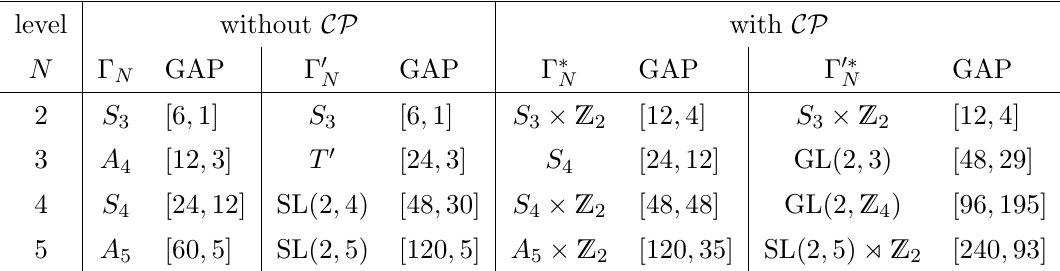
Table 1 . Overview of (cid:12)nite modular groups without and with a CP -like transformation (see section 2.2 for the details on CP ). The column GAP labels the groups according to ref. [50], where the (cid:12)rst number gives the order of the group. We remark several group isomorphisms: (cid:0) 2 (cid:24) = (cid:0) 0 (cid:24) = (cid:0) 0(cid:3) (cid:24) = S (cid:24) = D (cid:24) = S (cid:24) = T 0 Z (cid:0) (cid:3) 3 (cid:2) 2 12 , SL(2 ; 2) 3 and SL(2 ; 3) 2 2